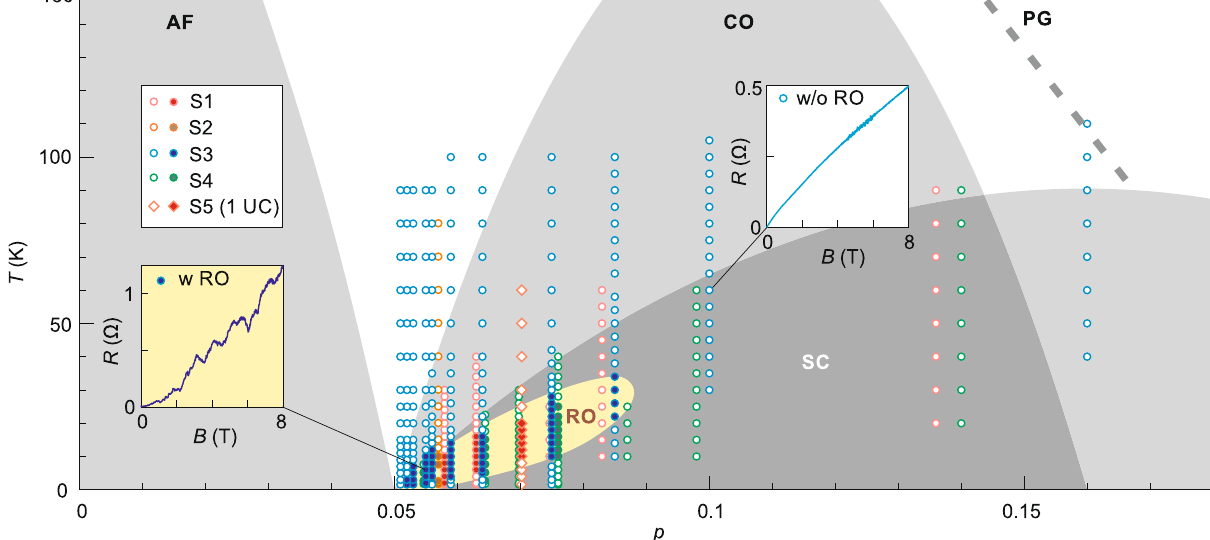
Fig. 3 Phase diagram of the Little-Parks like resistance oscillations in Bi-2212. Each symbol represents a fi xed set of temperature and doping at which the magnetoresistance measurement was carried out. Filled (empty) symbols indicate that resistance oscillations — RO — were present (absent). Exemplary traces are shown in the inset boxes. Overlapping data points at p = 0.055, 0.064, 0.07 and 0.075 are slightly shifted horizontally for better presentation. In the low temperature regime where resistance oscillations occurred, the actual measurements were taken with denser sets of temperature points (with steps of Δ T ¼ 0 : 5 K) than represented here ( Δ T ¼ 2 K). Gray shadows and dashed curve indicate the typical phases: anti-ferromagnetism (AF), charge order (CO), pseudo-gap (PG), and superconductivity (SC). Here data points marked as S1 and S4 are from the same fl ake but with two different pairs of contacts in two separate regions. S5 is a 1-UC Bi-2212 fl ake that is in the underdoped regime after exfoliation. Yellow shadow highlights the region where RO can be experimentally